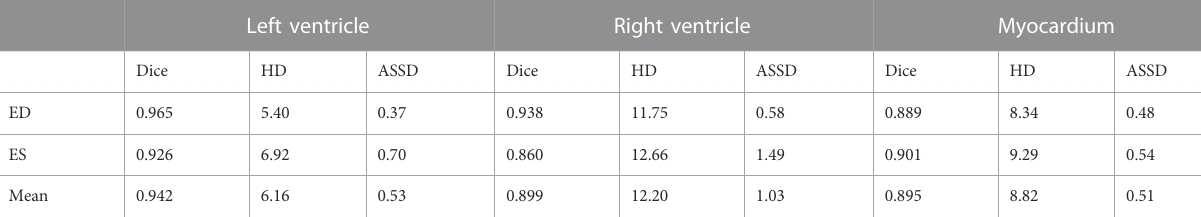
TABLE 2 Comparison of segmentation accuracy values based on improved U-Net network.